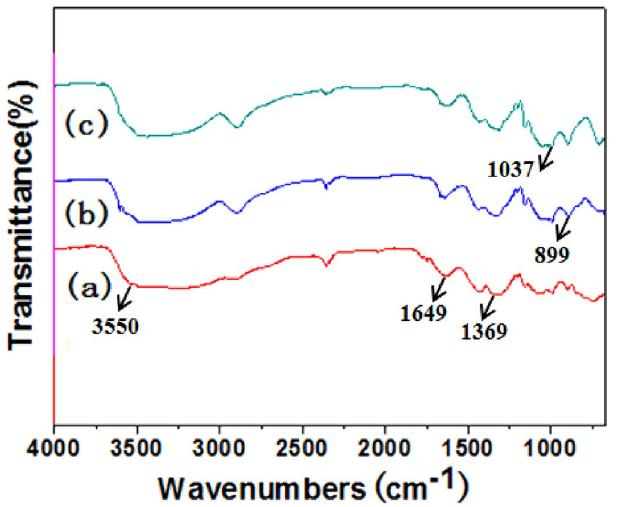
Figure 3. FT-IR spectra of samples synthesized at 60 °C with 65% (w/w) of ZnCl 2 solution for different times: ( a ) 1 h; ( b ) 2 h and ( c ) 3 h, respectively.